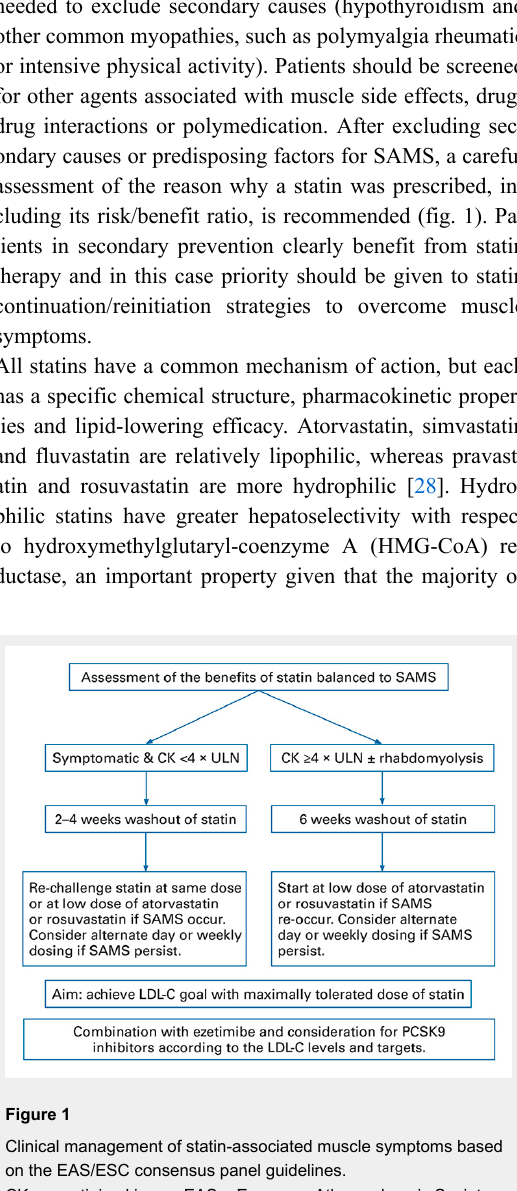
Clinical management of statin-associated muscle symptoms based on the EAS/ESC consensus panel guidelines. CK = creatinine kinase; EAS = European Atherosclerosis Society; ESC = European Society of Cardiology; LDL-C = low-density lipoprotein cholesterol; PCSK9 = proprotein convertase subtilisin kexin 9; SAMS = statin-associated muscle symptoms; ULN = upper limit of normal. Algorithm based on the EAS/ESC consensus document